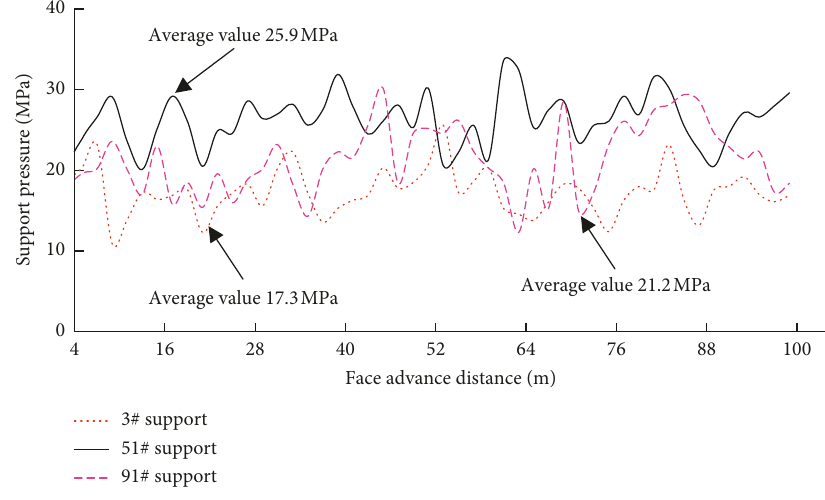
Figure 16: Variation curve of support load. Table 2: Statistics of weighting and support